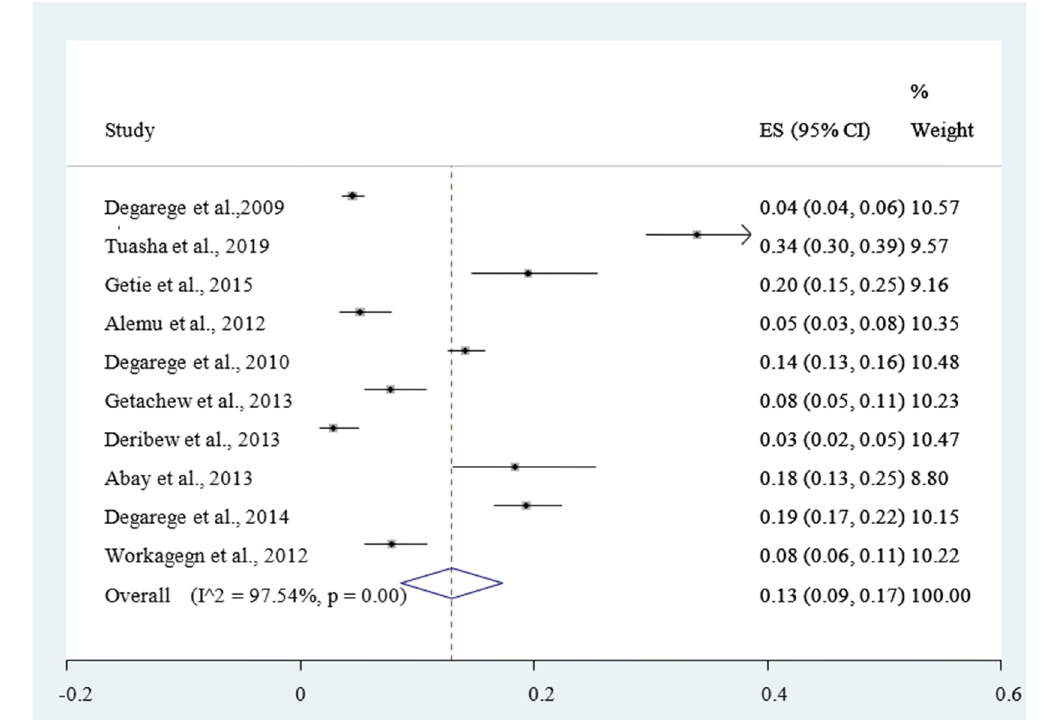
Figure 3. Funnel plot with 95% confidence limit of the comorbidity of geo ‐ helminths and malaria among the outpatients in Ethiopia, 2020.